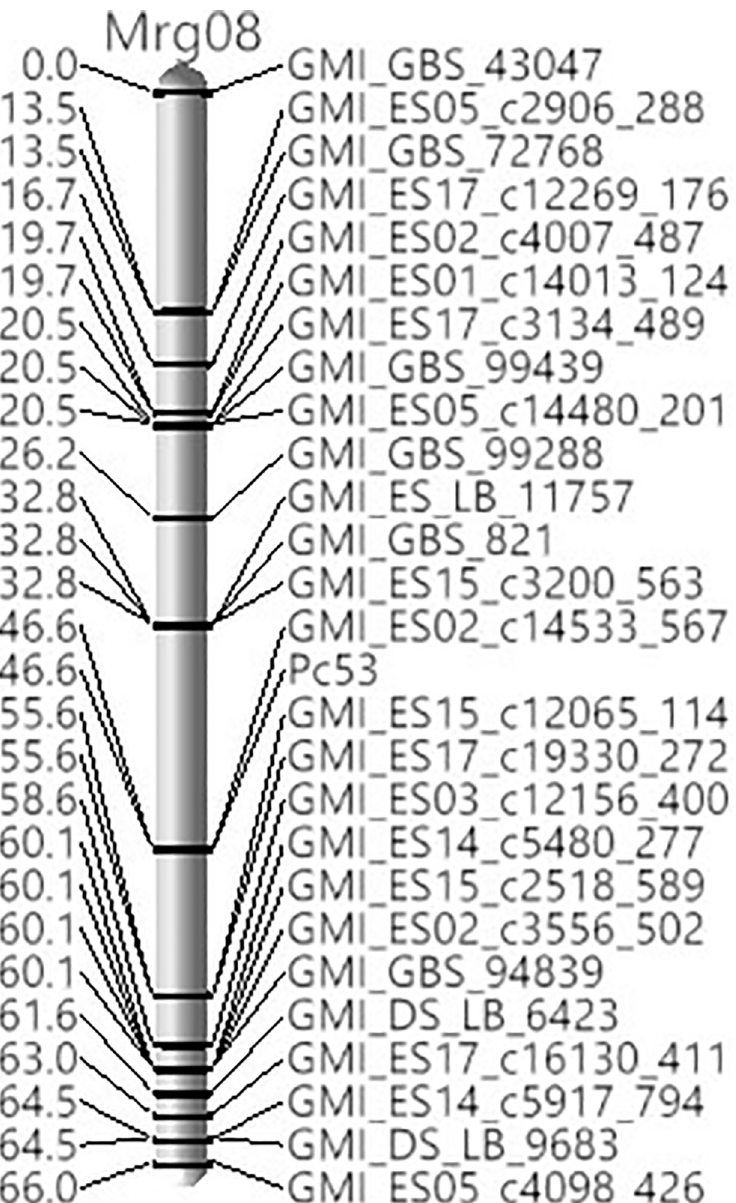
Fig 2. Genetic linkage map of Pc53 constructed with SNPs and oat F 5:6 RILs derived from a cross between Pc53 x Pc50. Linkage group Mrg08 is based on the oat consensus map of Chaffin et al. [23].